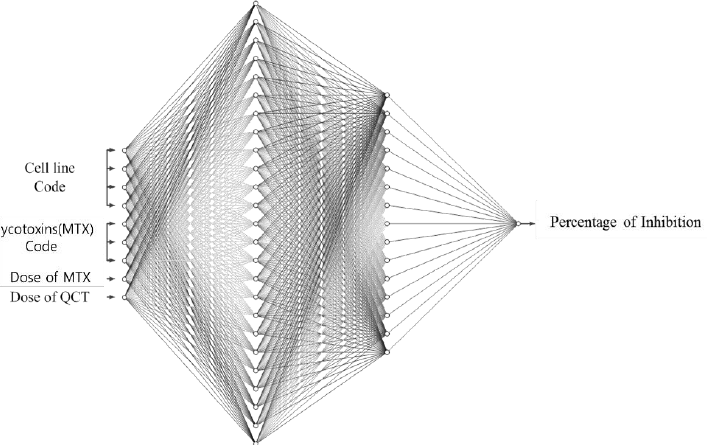
Figure 5. Architecture of artificial neural network (ANN) (9-20-15-1) for learning of % of inhibition. Biases of nodes are omitted in this figure, where four input terminals are used for indicating cell lines and three input terminals are to determine MTXs and other two input terminals are for the dose of MTX and QCT, respectively. Also, the single output terminal is for % of inhibition.